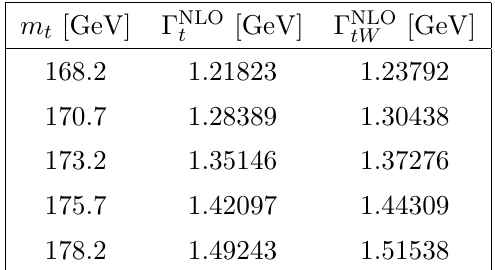
Table 1 . Top quark decay widths for (cid:12)ve values of m gauge boson o(cid:11)-shell e(cid:11)ects included and (cid:0) NLO boson as used in the NWA. Massless bottom quarks are